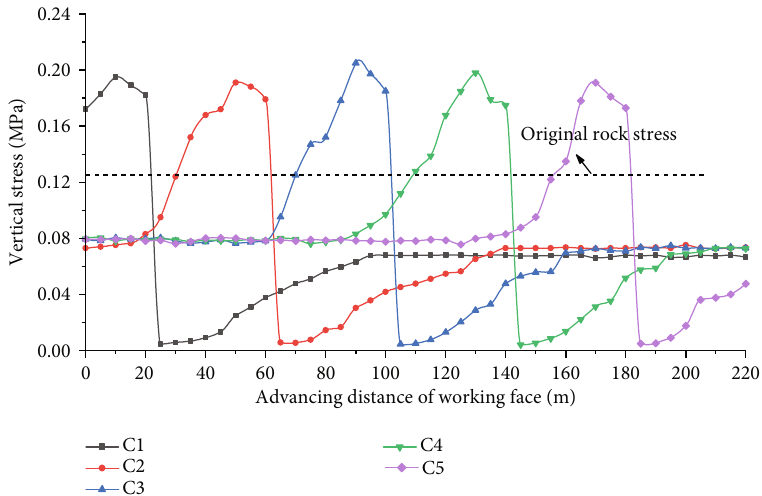
Figure 8: Stress variation diagram of overburden due to the mining in fl uence (C monitoring line).